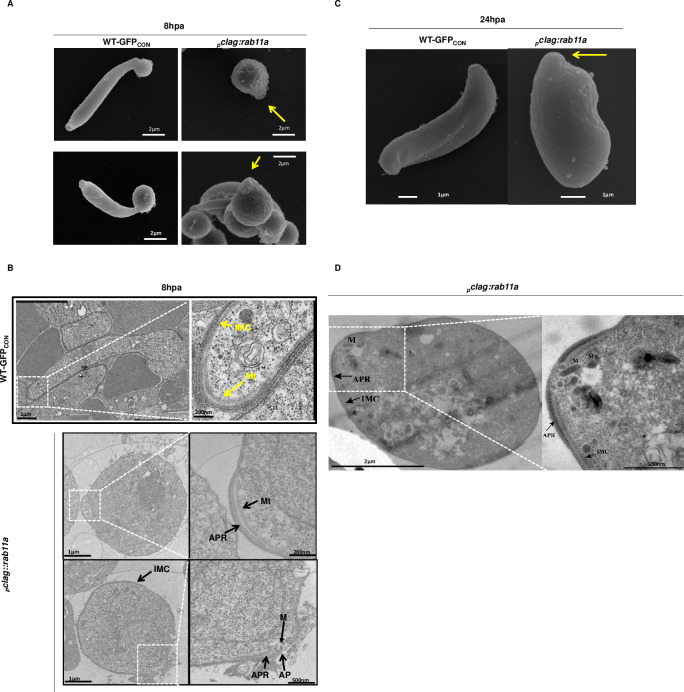
Ultrastructural analysis of pclag::rab11a 8h zygotes.A. SEM images of 8h pclag::rab11a zygotes showing the typical small yet specific membrane extension (see yellow arrow) as compared to retort outgrowth in 8h WT-GFPCON zygotes. B. TEM images of 8h pclag::rab11a zygotes showing integrity of Apical Ring (APR) with aperture (AP), IMC, subpellicular microtubules (Mt) and micronemes (M). C. SEM of left, 24h WT-GFPCON and right, pclag::rab11a “ookinetes”, the apical prominence is arrowed in the latter. D. TEM images of two magnifications of 24hpa pclag::rab11a “ookinetes” demonstrating the fully developed nature of the apical prominence.